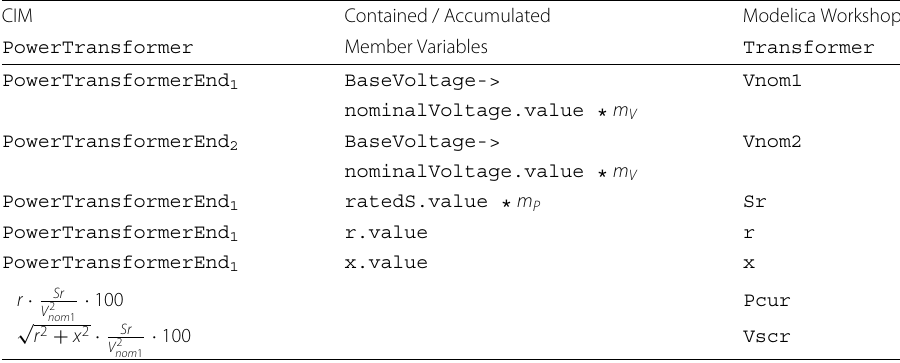
Table 1 CIM PowerTransformer to Modelica Workshop Transformer mapping CIM